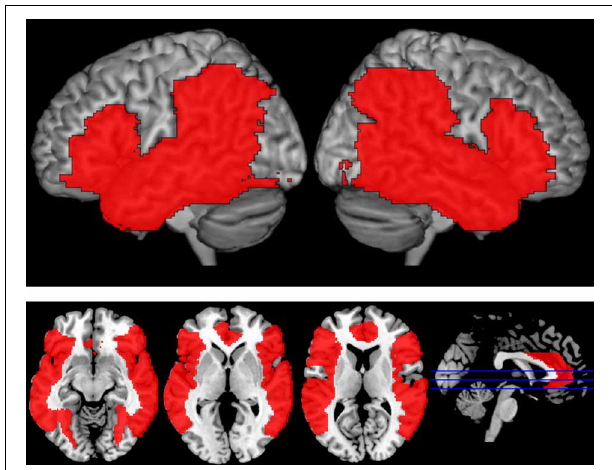
FIGURE 2 | Language Mask. Areas in red reflect the fronto-temporo-parietal language mask that was applied at the third level analysis to limit analyses to language-relevant regions. Regions were selected based on previously published reports and included bilateral IFG (BA 44, 45, 47), anterior cingulate, insula, STG, MTG, ITG, fusiform gyri, angular gyri, inferior parietal lobule, and supramarginal gyri.